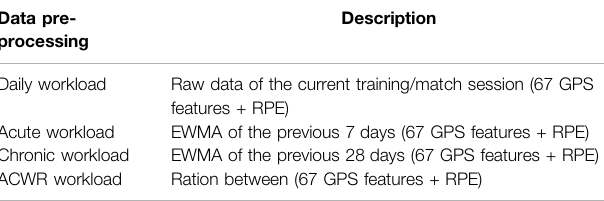
TABLE 2 | Data pre-processing approaches description.